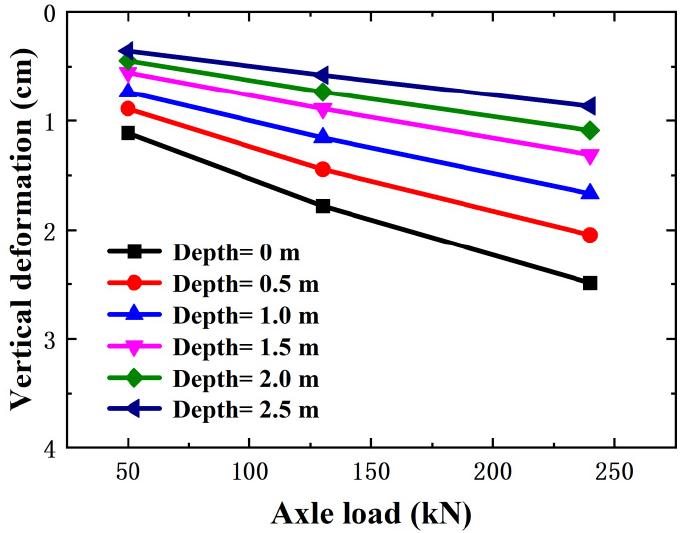
Figure 23. Change curve of roadbed settlement under different traffic